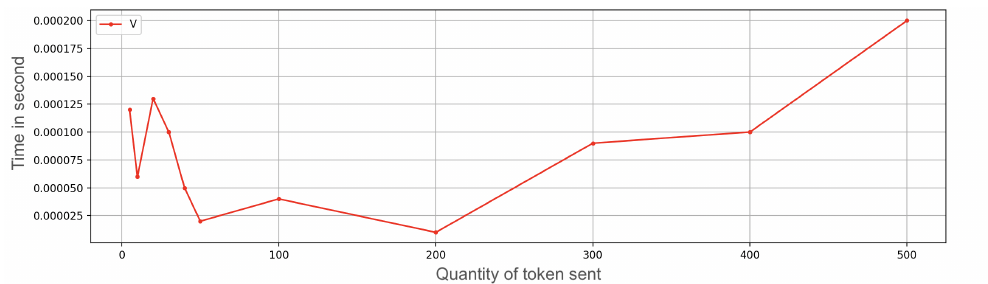
Figure 9. Exchange token time on iPhone 7 without the secure enclave execution measuring average (A) of the ramp test.